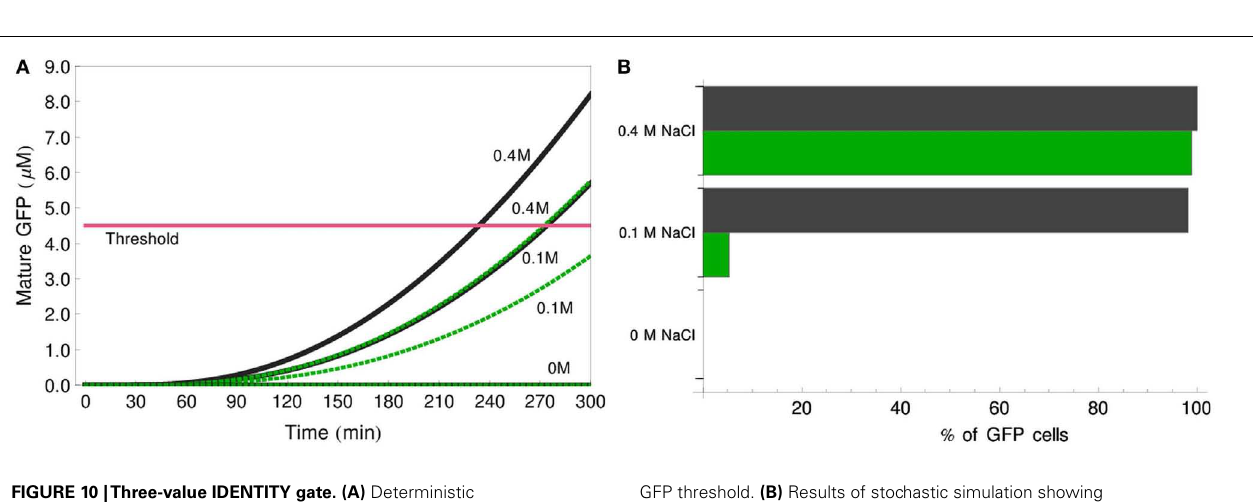
FIGURE 10 |Three-value IDENTITY gate. (A) Deterministic simulation showing the amount of GFP produced by each of the two reporter cell populations, for stimulation with 0, 0.1, or 0.4M NaCl. Black lines – reporter cells with wild-type Ste2, green dotted lines – reporters carrying Ste2 F262A .The pink line depicts the 4.5- µ M